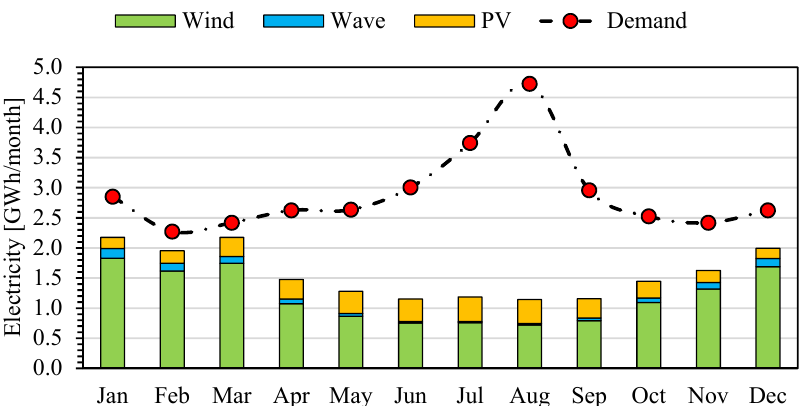
Figure 5. Energy demand and potential renewable energy production in Lipari Island.